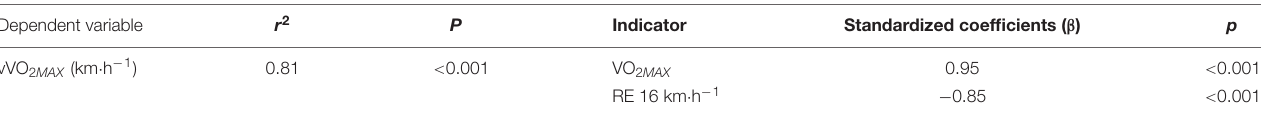
TABLE 2 | Predictors of performance during maximal incremental running test (vVO 2 MAX